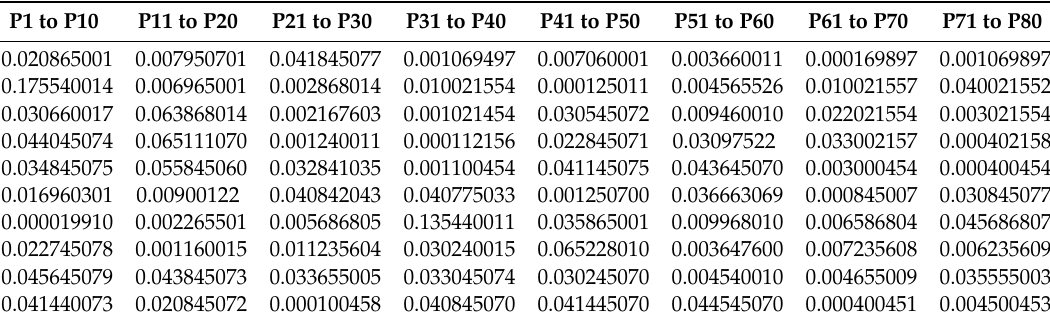
Table 3. ANP weights ( t i ) of the workers (P1, P2, P3, ... P80).